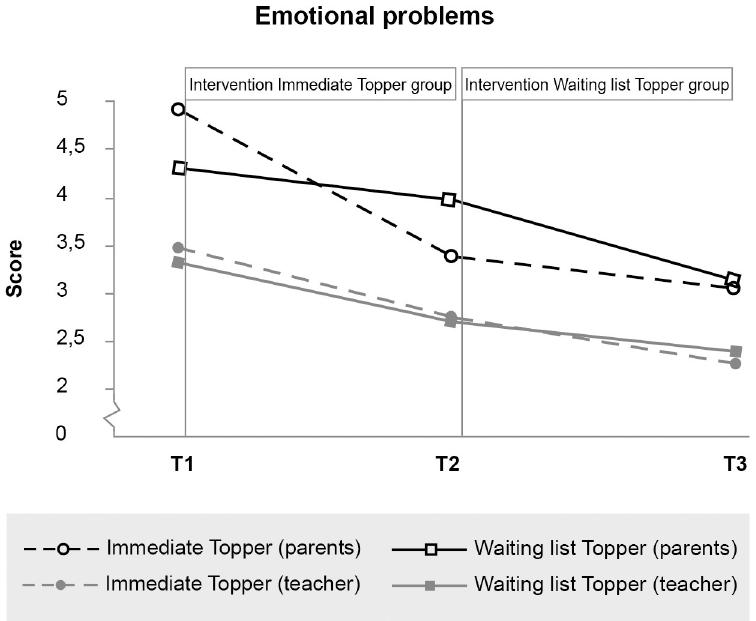
Fig 3. Significant effect of Topper Training on parent-reported (but not teacher-reported) emotional symptoms. N.B. The Figure plots a decrease of emotional symptoms during Topper Training period: between T1 and T2 for Immediate training group and between T2 and T3 for Waiting list